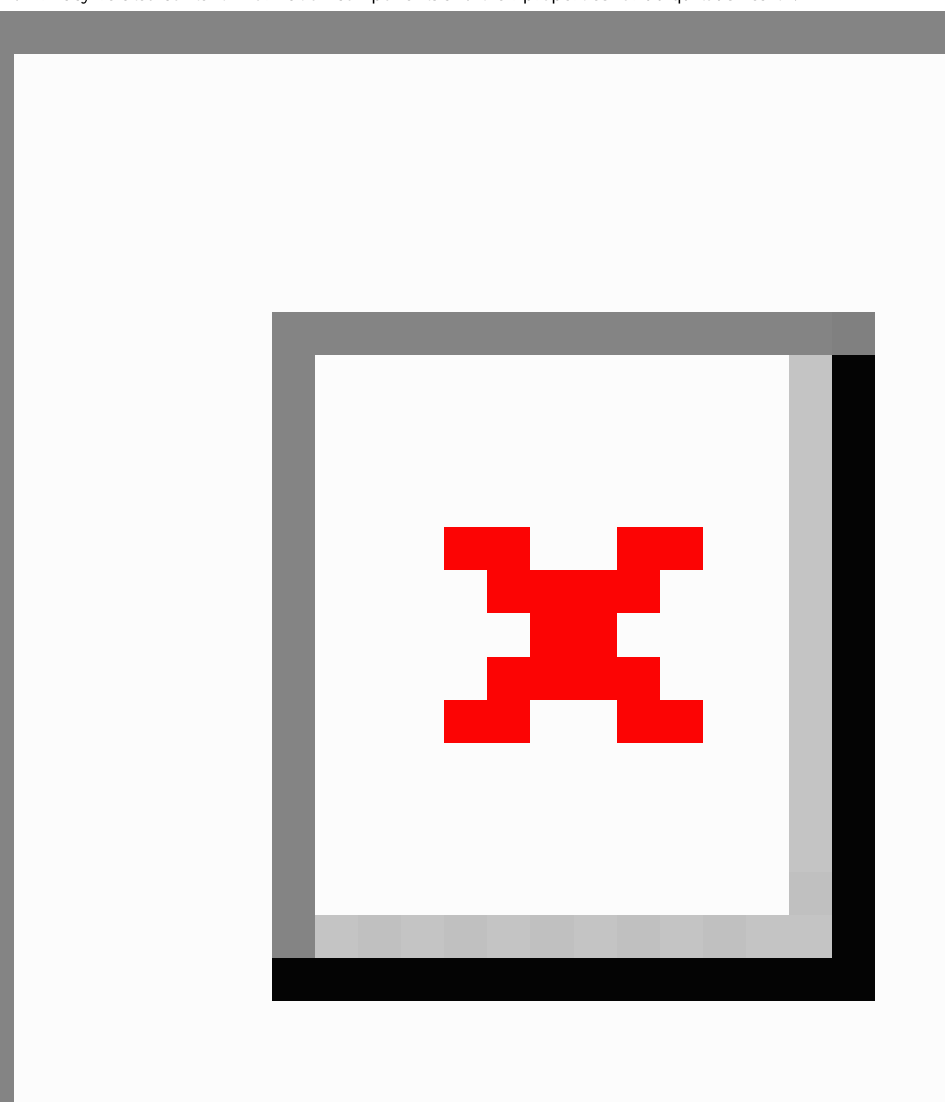
Figure 2. Privacy-related context information components and their properties for ubiquitous